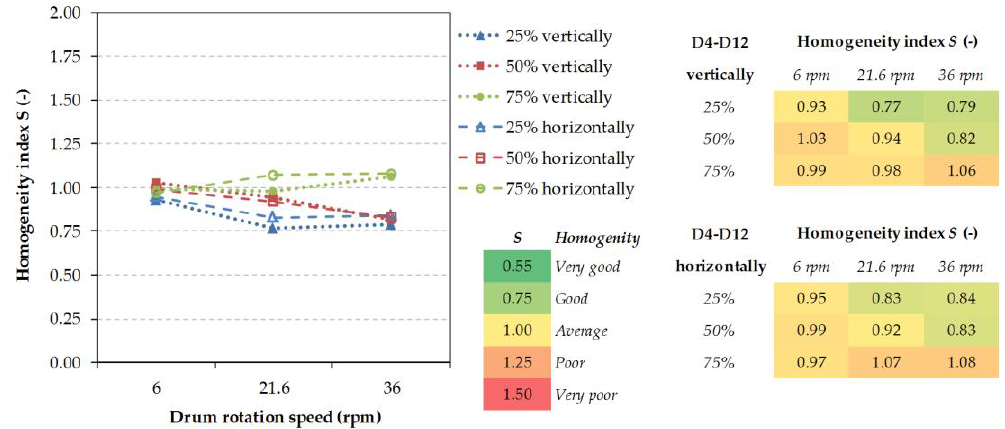
Figure 13. Resulting homogeneity indices for different operating conditions (D4 – D12 particles).